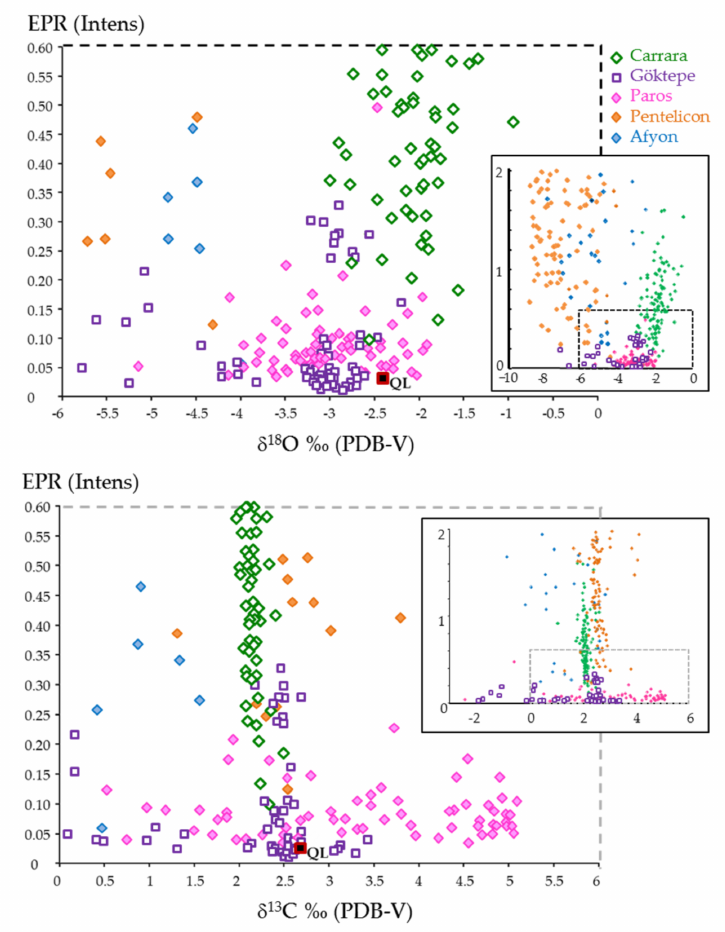
Figure 12. Scatterplot and close-up view (area with dashed line) of EPR (Intens) versus O and C isotopic data of the archaeological sample QL (red and black square) with data compiled from [14,30] for the most important fine-grained marble